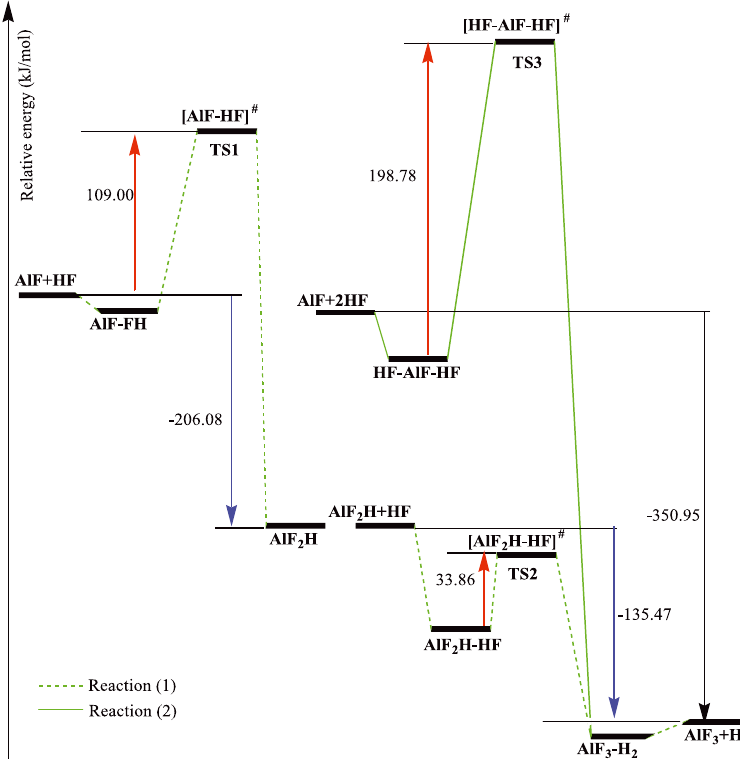
Figure 7. Potential energy surface, reaction energies (kJ mol -1 ) and activation barrier energies (kJ mol -1 ) for reaction between AlF and